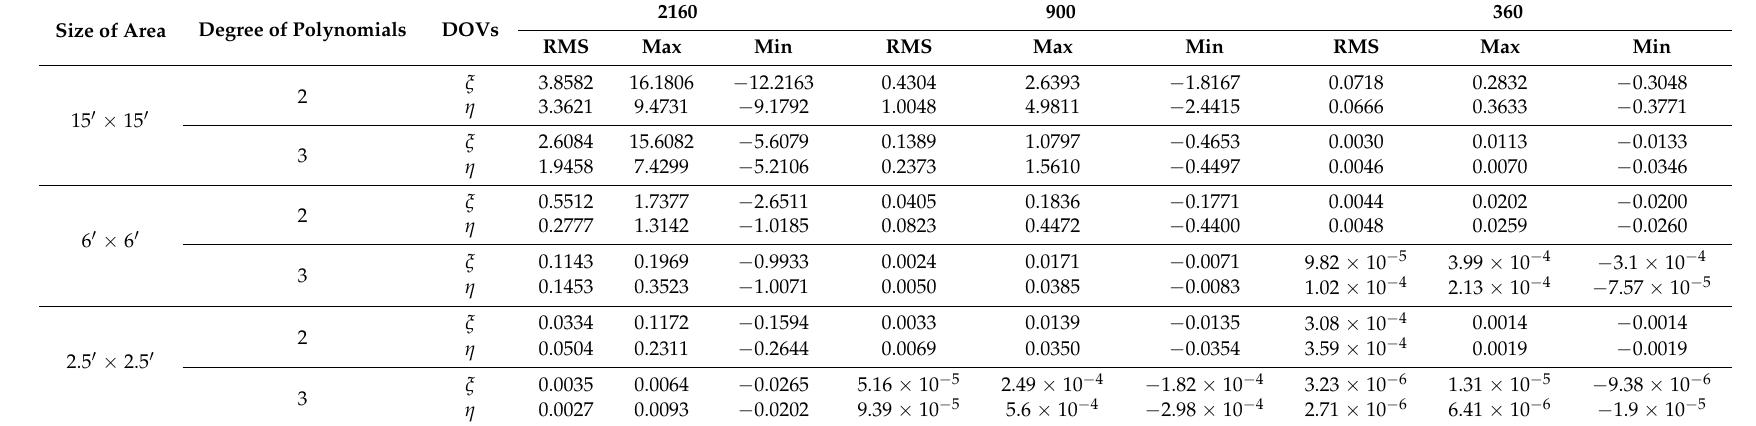
Table 4. Numerical results of polynomial fitting in the